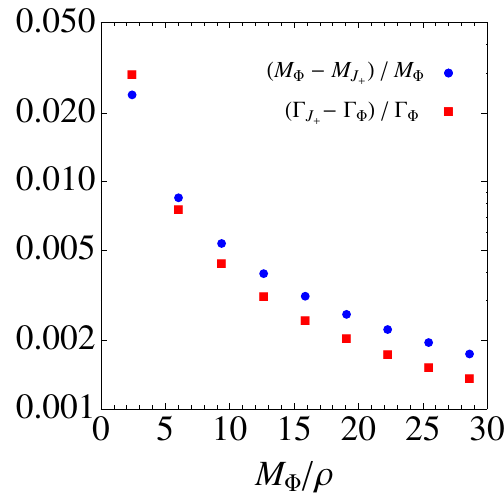
Figure 6 . Relative difference, in the plane ( M, Γ) , between the positions of the zeros of Φ( p ) and of J + ( p ) computed in the second Riemann sheet, corresponding to the poles and zeros of the Green’s function G A ( y 0 , y 0 ) , respectively. These zeros are denoted by ( M Φ , Γ Φ ) and ( M J